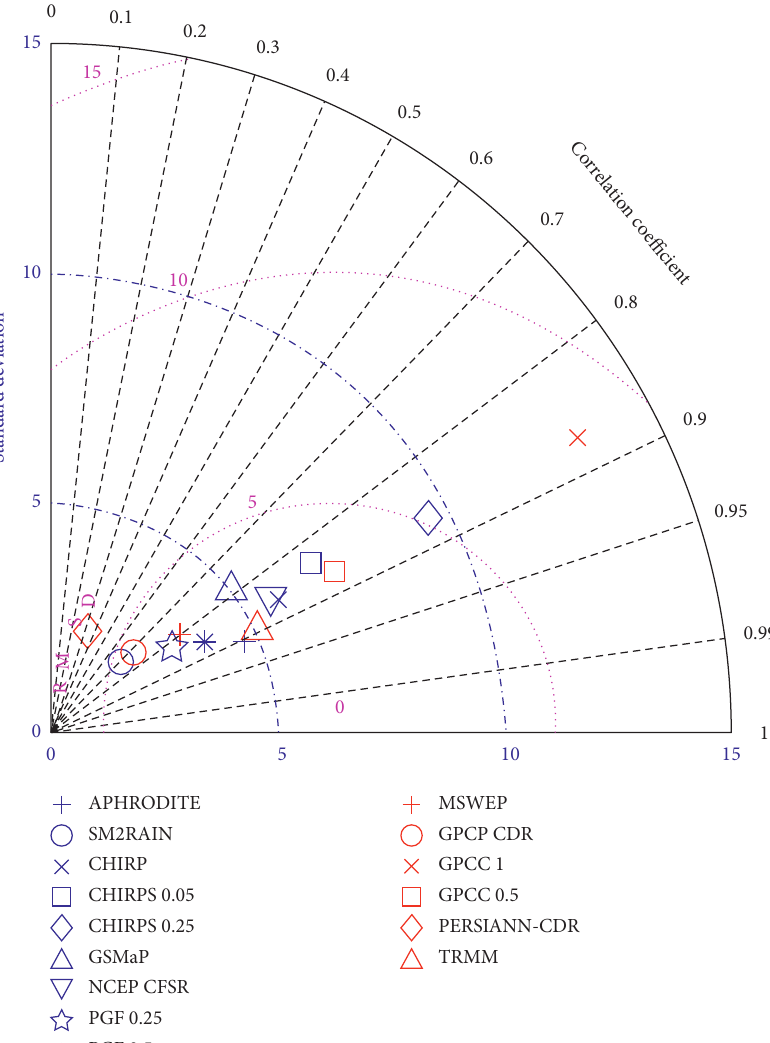
Figure 4: Taylor diagram depicted for all 15 gridded rainfall datasets against IMD gridded dataset at monthly time